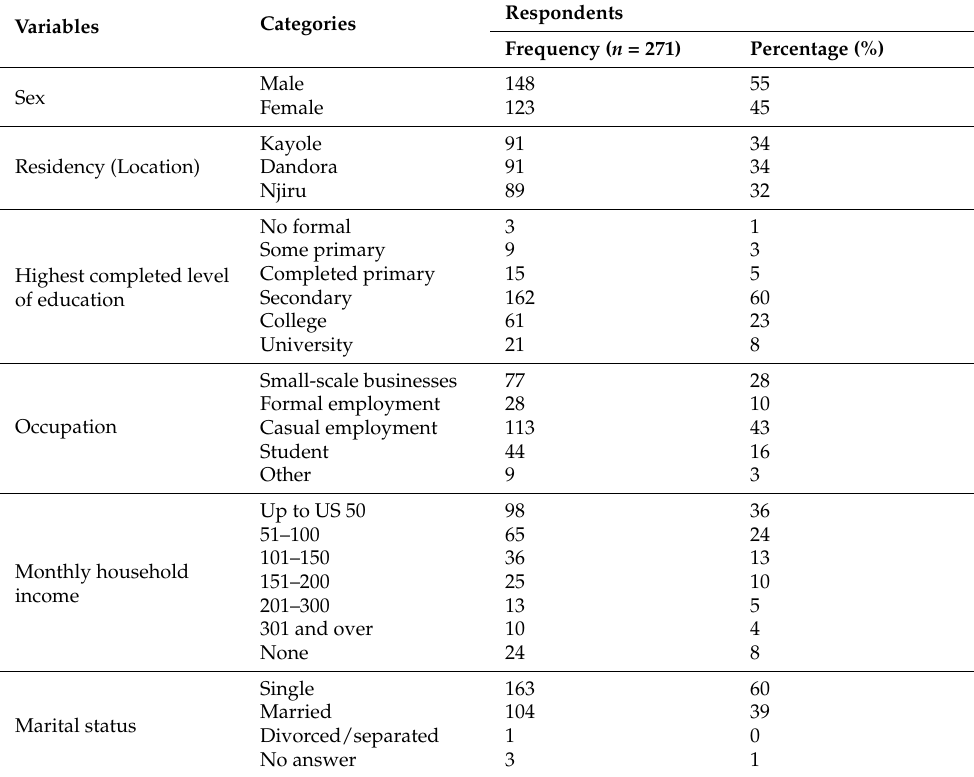
Table 2. Distribution of demographic